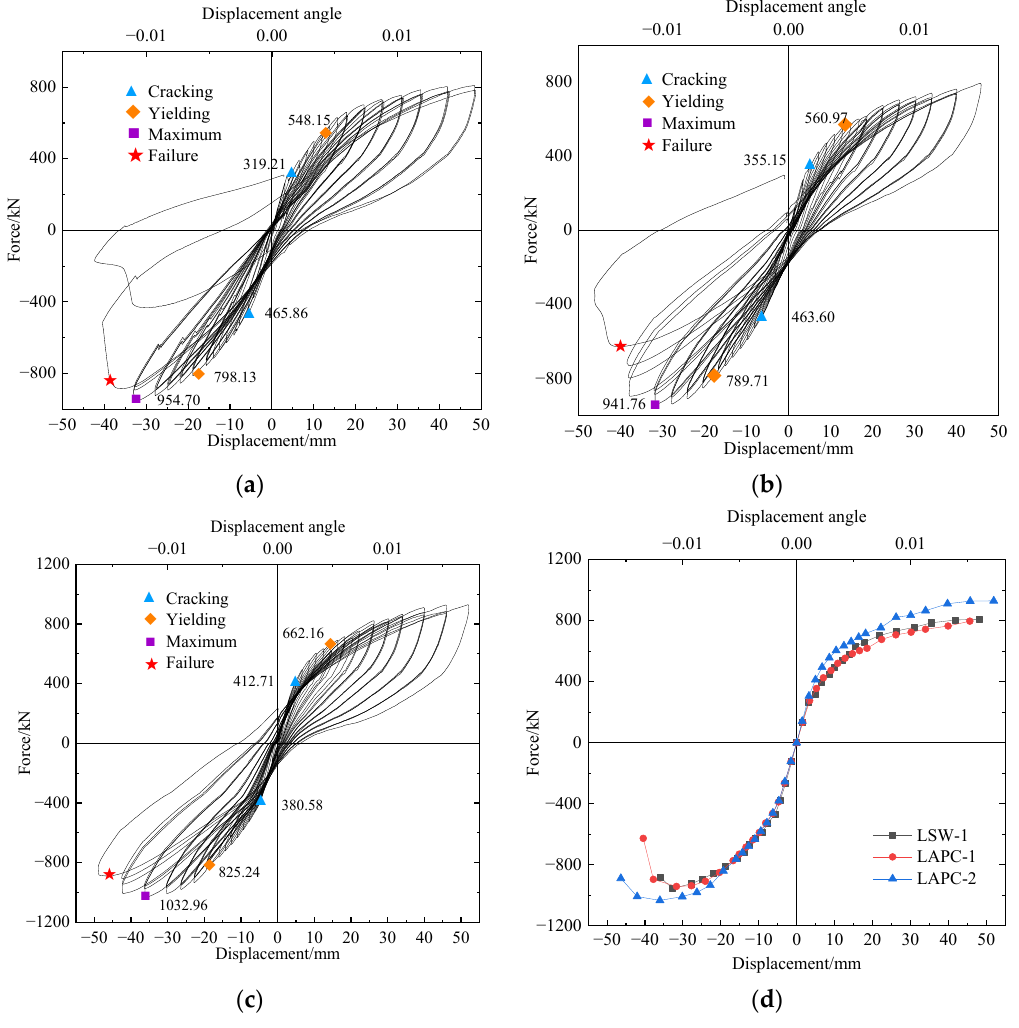
Figure 8. Comparison of hysteresis curves and skeleton curves of specimens: ( a ) hysteresis curve of LSW; ( b ) hysteresis curve of LAPC-1; ( c ) hysteresis curve of LAPC-2; and ( d ) skeleton curves of the three specimens.